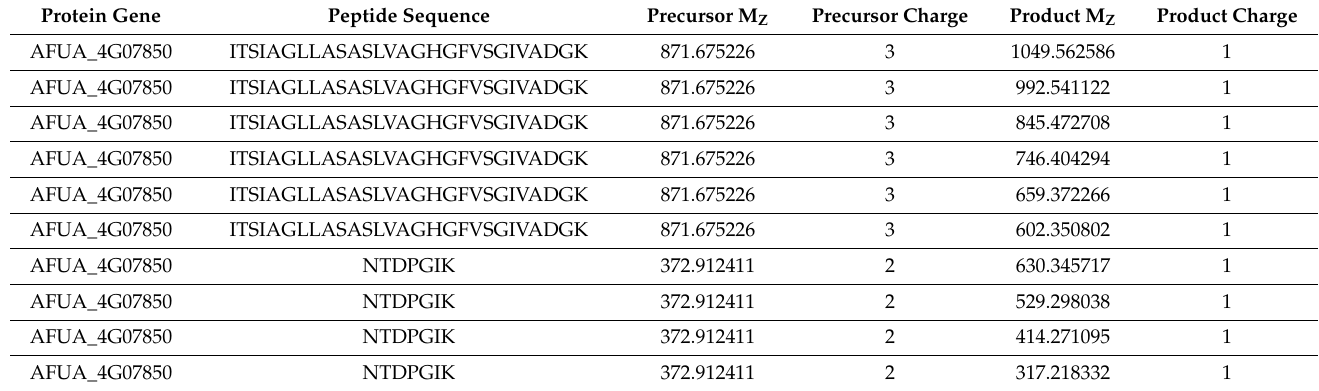
Table 1. Peptide